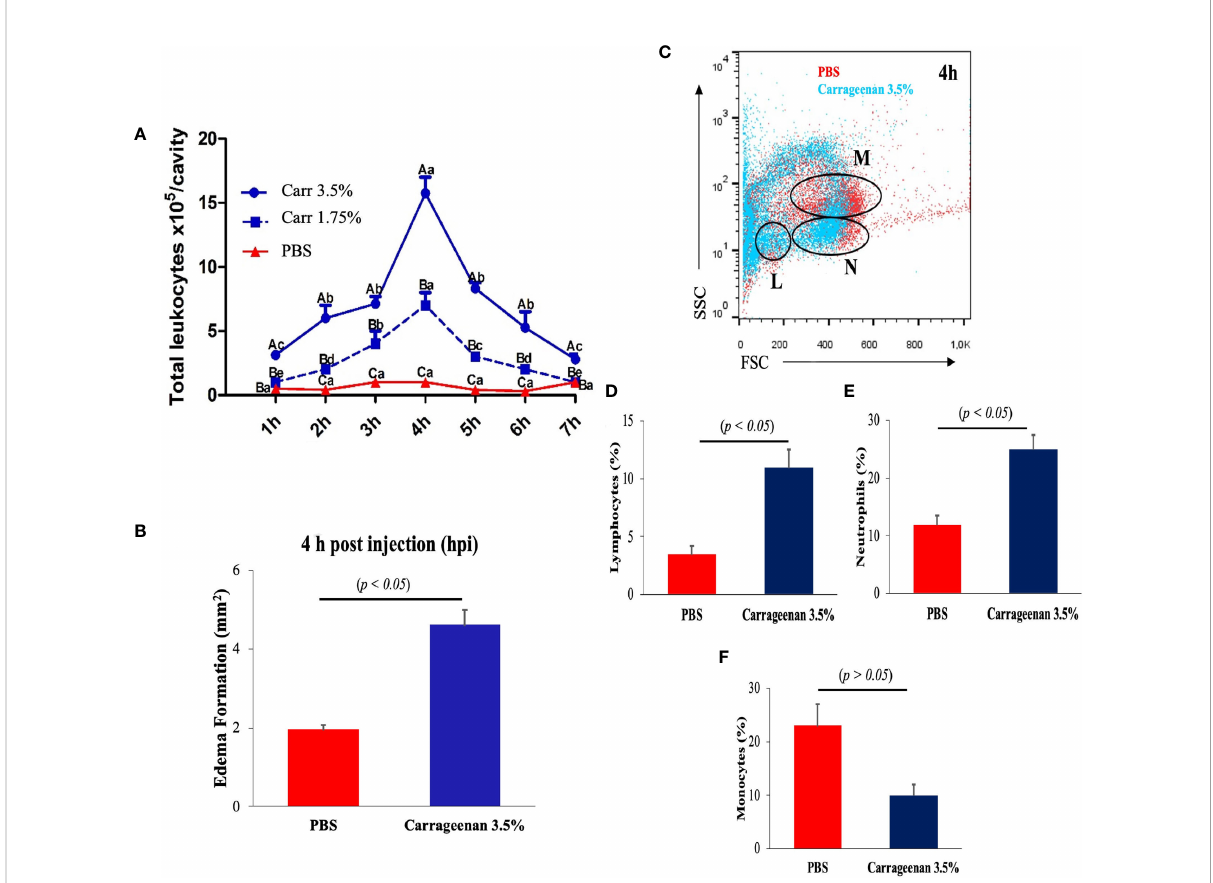
FIGURE 2 Intraperitoneal injection of l -CGN stimulates a highly selective cellular immune response in zebra fi sh. (A) The time-dependent in fi ltrating mean number of total leukocytes in control (PBS) and l -CGN-injected fi sh with two different concentrations. (B) Quanti fi cation of the progressive mean abdominal edema expansion using the highest (3.5%) l -CGN concentration 4h after the injection. (C) Representative dot plot showing the gating used to discriminate between lymphocytes [L], neutrophils [N], and monocytes [M] present in the ascites recovered from the PBS (red) or 3.5% l -CGN-treated (blue) fi sh 4h post-injection. (D – F) Quanti fi cation of data in (C) by cellular type. (Note the resulting inhibition in the monocyte fraction) (n = 21 fi sh per group) Results were analyzed using an unpaired t-test ( p < 0.05) respective to the control value. Error bars indicate